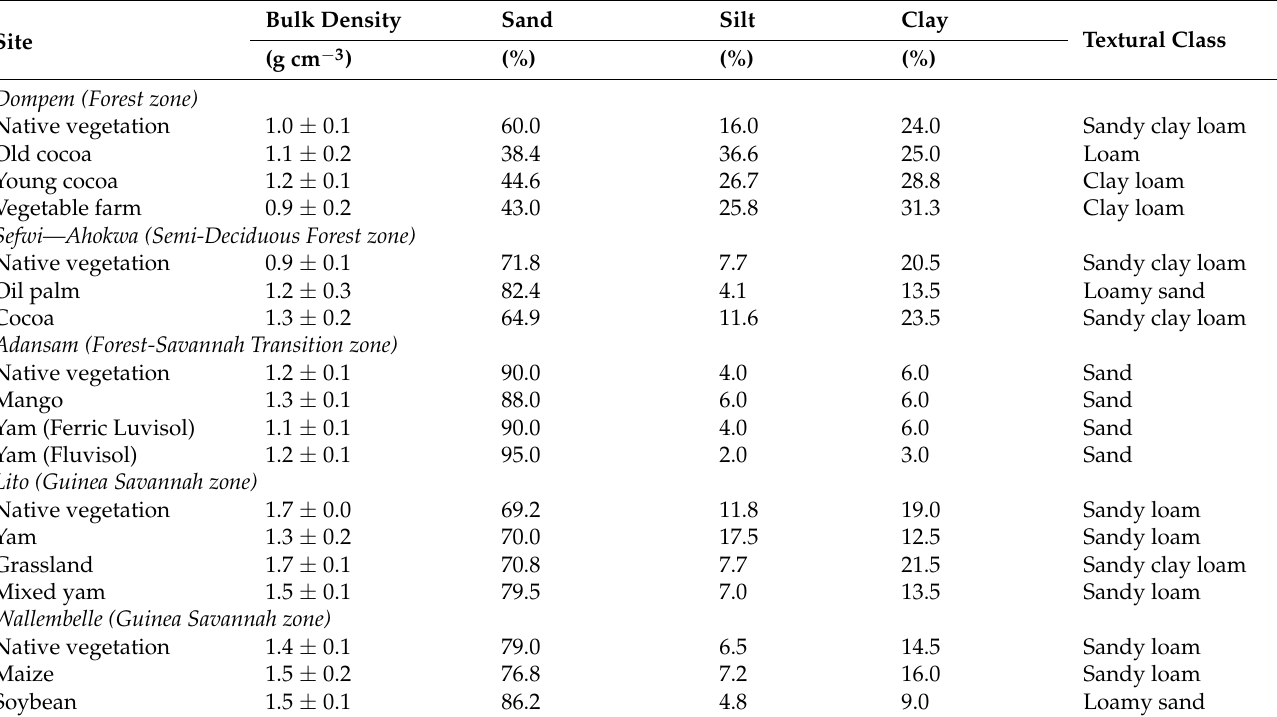
Table 1. Bulk density, particle size and textural classes of soils from native vegetation and croplands of each of the reconnaissance survey sites ( n = 5 ± One standard error of